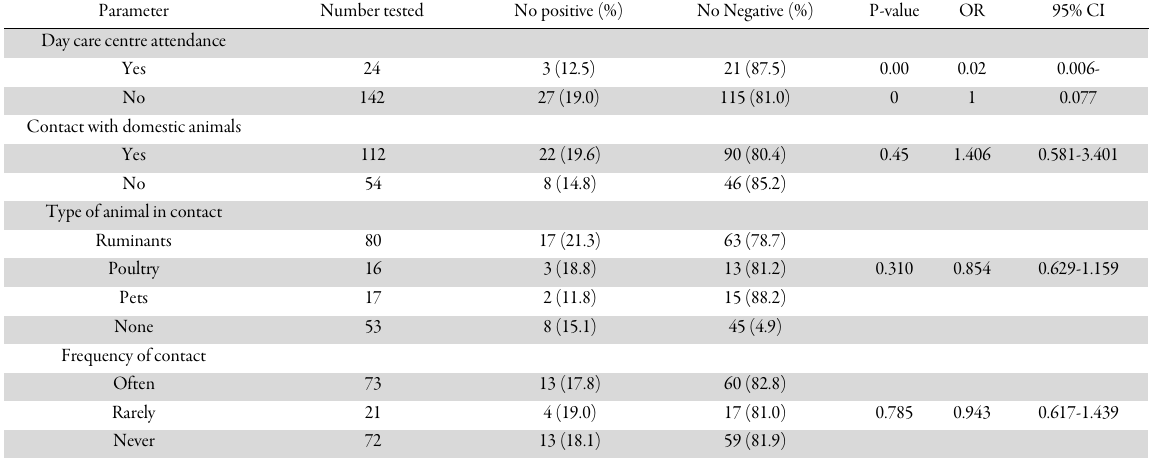
Table 4. Prevalence of Rotavirus infection in diarrheic children in relation to attendance at day care and contact with animals in Yobe state, Nigeria